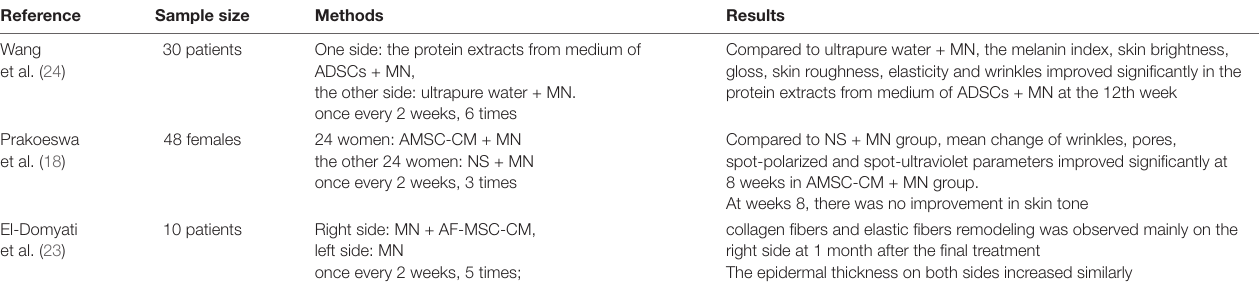
TABLE 5 | Facial rejuvenation studies with MN plus with